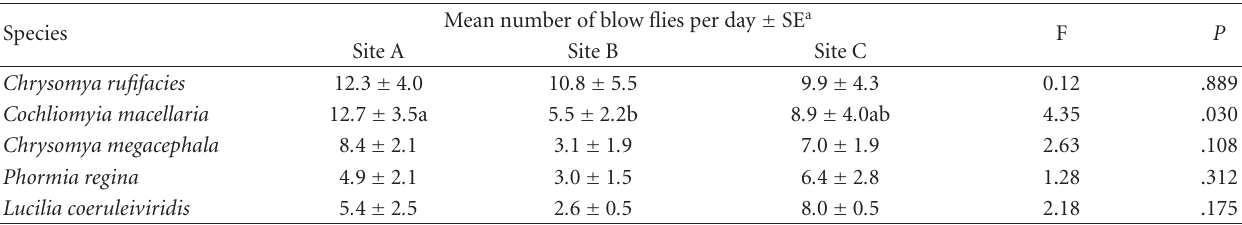
Table 5: Analysis of variance for five species of blow fly adults over a 10-day period (block) among three sites (main e ff ect), each with a single alligator